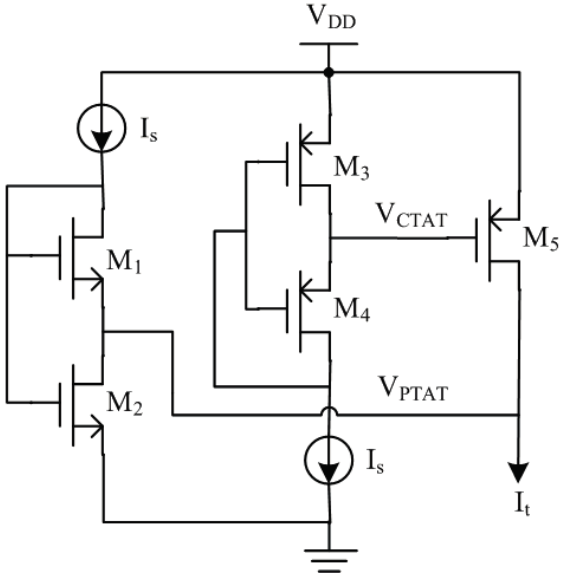
Figure 3. Proposed PTAT current